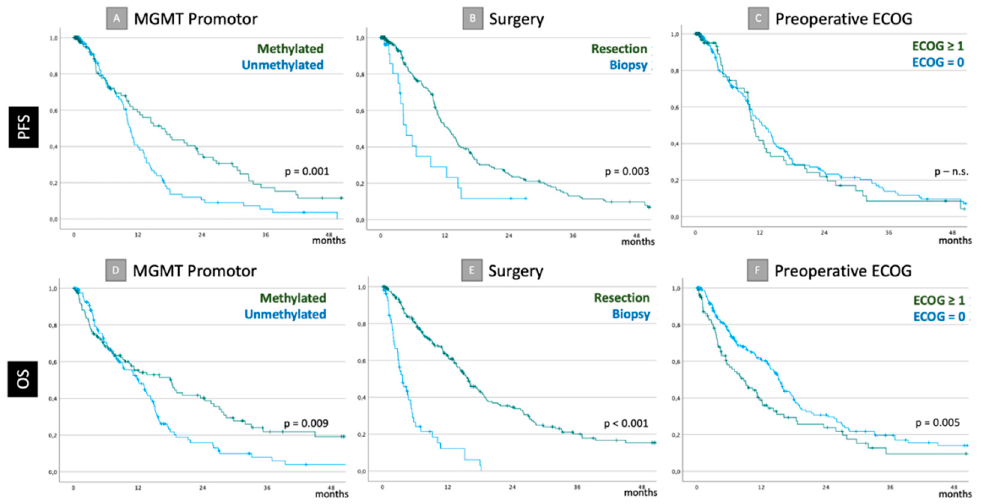
Figure A1. PFS and OS data for the entire cohort are provided as Kaplan–Meier graphs in relation to MGMT promotor methylation (correspondingly ( A , D )), surgical modality ( B , E ) and preoperative ECOG ( C , F ). Significance level is provided in conformity to LogRank tests. Statistically significant differences were revealed in all pairs, except preoperative ECOG impact on PFS ( C ).